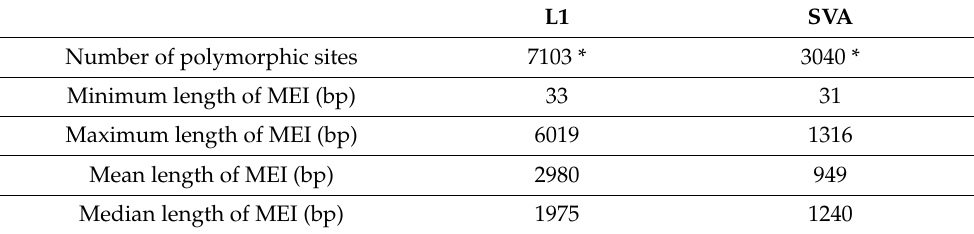
Table 2. Overview of identified polymorphic non-reference MEIs in the new panel of the